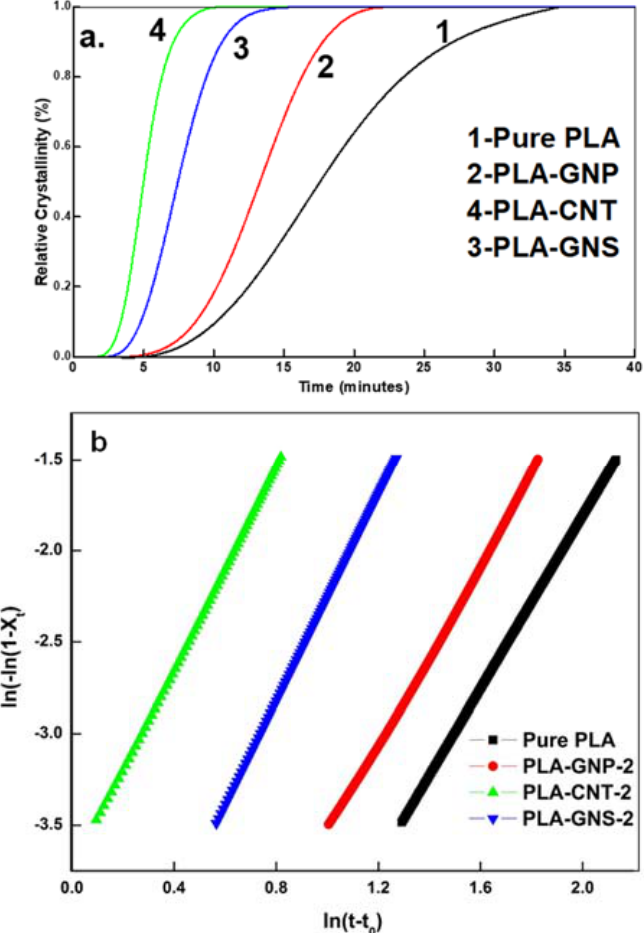
Figure 3. ( a ) Relative crystallinity vs. time plots of pure PLA and its hybrids with various nanoparti-